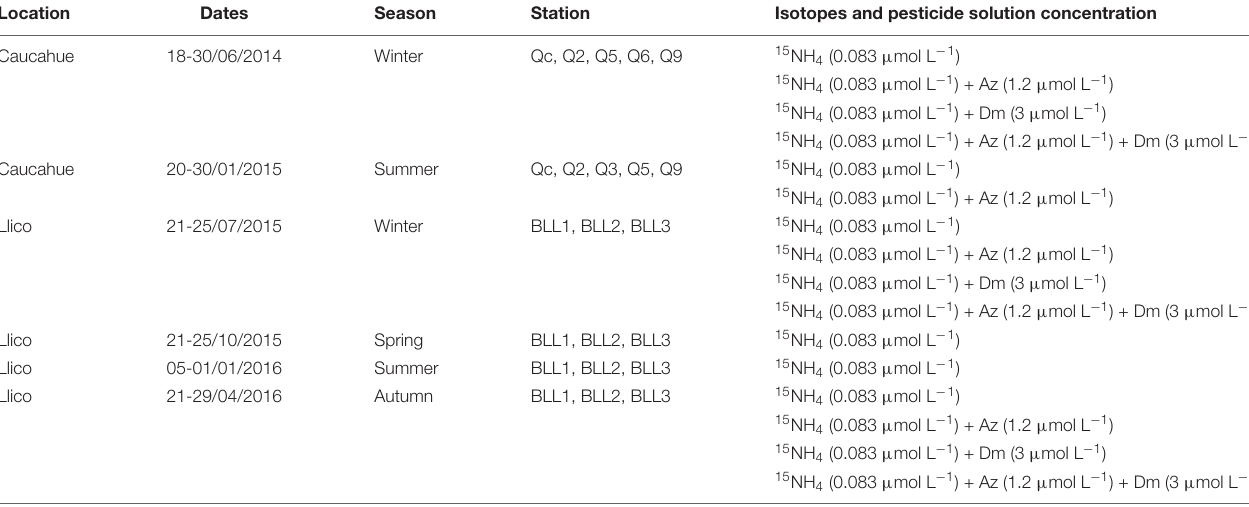
TABLE 2 | Summary of in situ ammonium assimilation experiment setup during Llico and Caucahue campaigns.